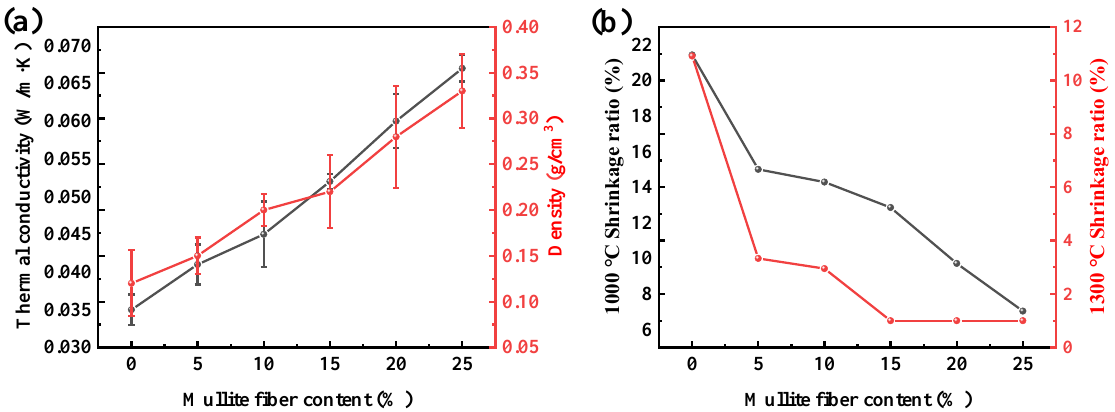
Figure 2. Density and thermal conductivity of AM samples as a function of mullite fiber content ( a ); thermal shrinkage ratio of AM samples after heat treatment at 1000 °C and 1300 °C as a function of mullite fiber content ( b ).